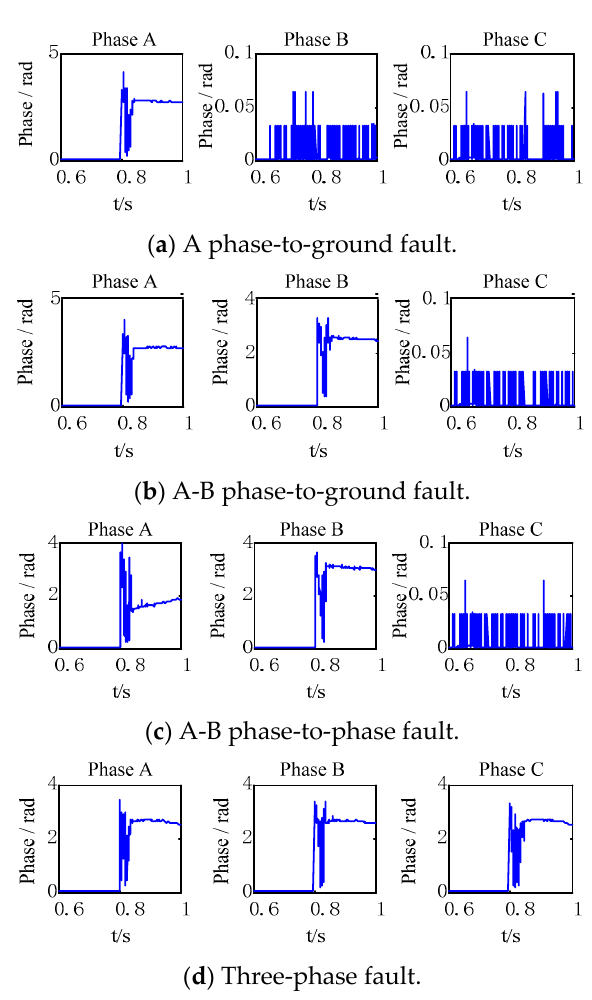
Figure 3. Typical fault simulation results.